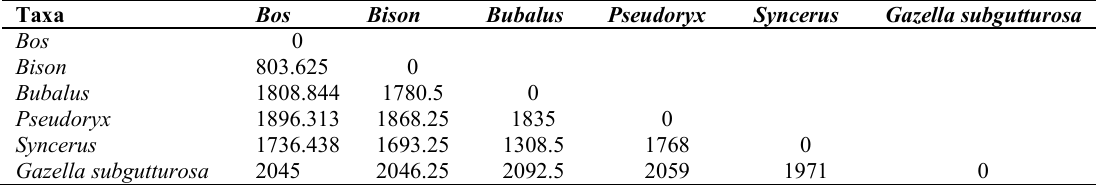
Fig. 5. Maximum Likelihood tree based on the GTR+G+I distance using complete mitochondrial genome sequences. The numbers on each branch correspond to the bootstrap support values. The tree was rooted with T. oryx ; [{(( Bu. depressicornis + Bu. bubalis )+ Syncerus caffer )+ {{( B. frontalis + B. javanicus )+ (( Bi. priscus + Bi. bison )+ ( B. grunniens + B. mutus ))}+ {( Bi+schoetensacki + Bi. bonasus )+ ( B. primigenius + B. taurus )+ ( B. indicus )}+ P. nghetinhensis ]. Table 6. Genetic distances between genera of the tribe Bovini based on complete mitochondrial sequences.